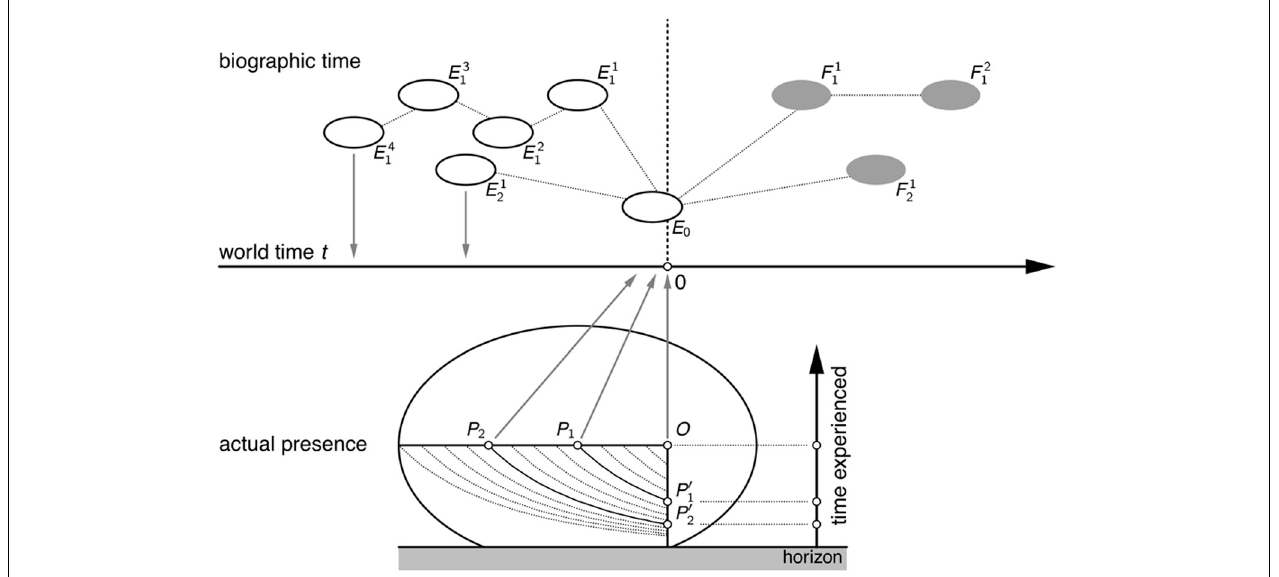
FIGURE 1 | Two dimensions of time. Upper part: biographic time consists of passed ( E n i ) or anticipated ( F n i ) episodes, connected by logical or material dependencies (dotted lines) and thus partially ordered. Lower part: the actually present episode, E 0 , comprising subsequent events P 1 , P 2 ,... that are co-present ( P (cid:3) 1 , P (cid:3) 2 ,... ) to the observer’s consciousness at O and ordered along the dimension of experienced time (vertical arrow). The two systems of events, inter-episodic